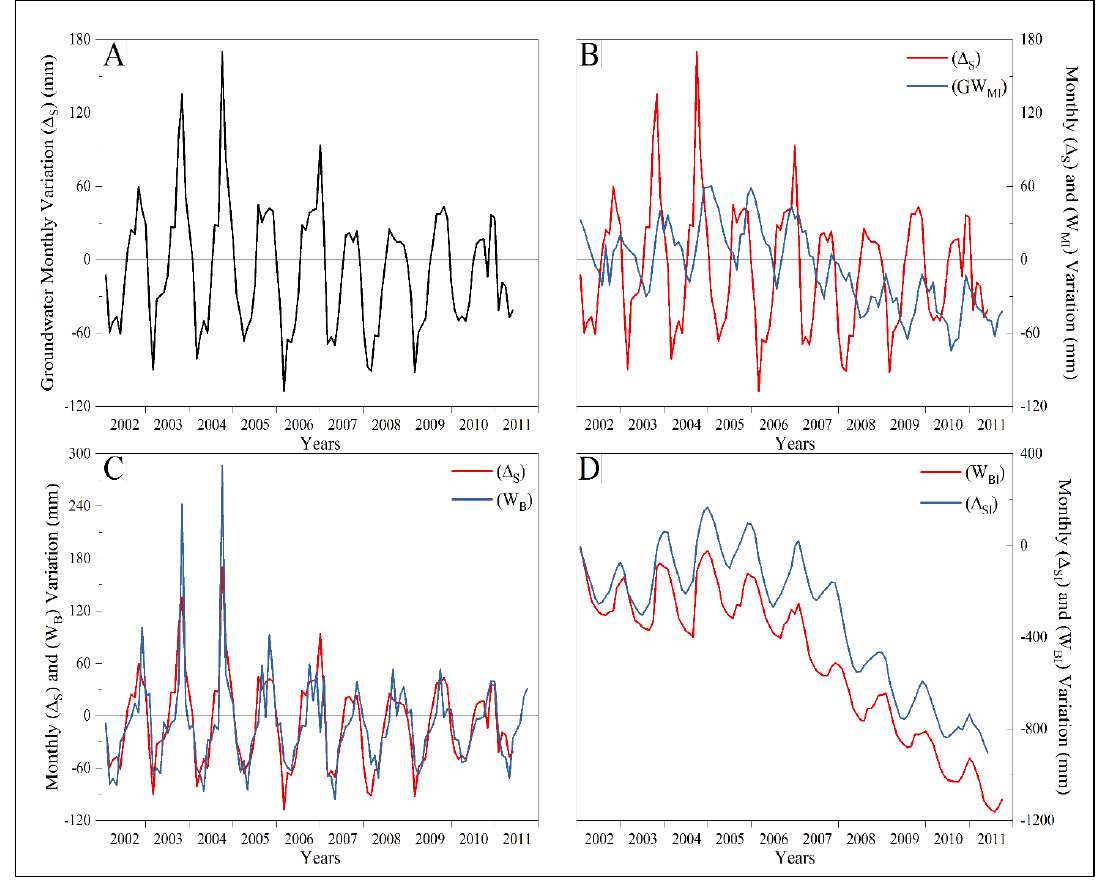
Figure 5. ( A ) Measured monthly variation in groundwater level (Δ S ). Y axis: (Δ S ) variation (mm). ( B ) Variation in groundwater level (Δ S ) compared with GRACE—derived water mass variation (GW MI ). Y axis: (Δ S ) and (GW MI ) variation (mm). ( C ) Variation in groundwater level (Δ S ) compared with net monthly precipitation (W B ). Y axis: (Δ S ) and (W B ) variation (mm). ( D ) Accumulated groundwater height variation (Δ SI ) compared with accumulated net precipitation (W BI ). Y axis: (Δ S ) and (W BI ) variation (mm), during the study period (January 2002—December 2011). The value of zero on the y—axis in A, B, and C indicates no change in water mass.